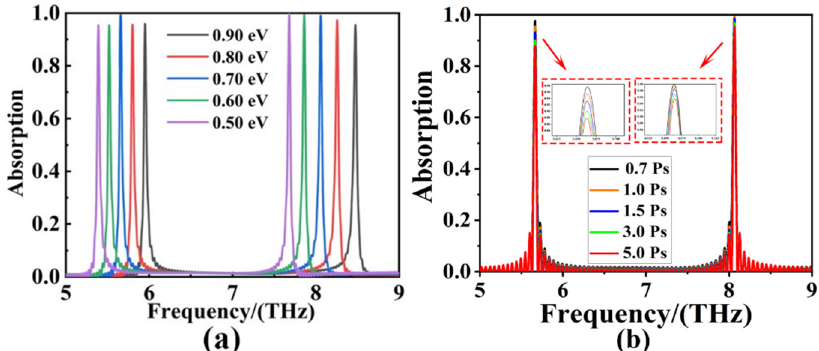
Figure 5. ( a ) Absorption changing spectra with the Fermi level of graphene increased from 0.50 eV to 0.90 eV. ( b ) Absorption spectra obtained by increasing the relaxation time of graphene from 0.70 Ps to 5.0 Ps.